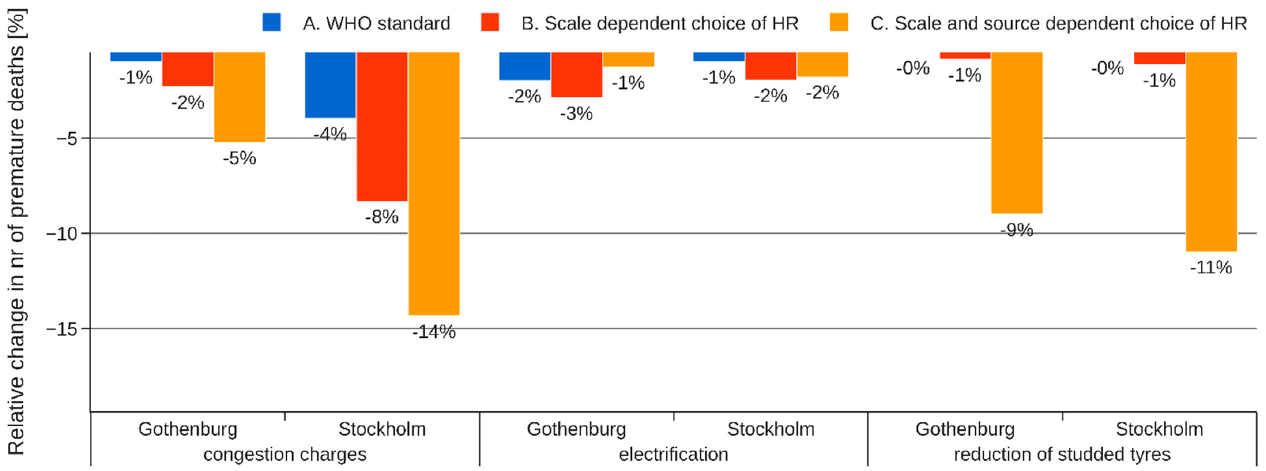
Figure 5. Relative change in mortality attributed to traffic air pollution for the 3 abatement strategies applied in Gothenburg and Stockholm, using 3 different HIA approaches.